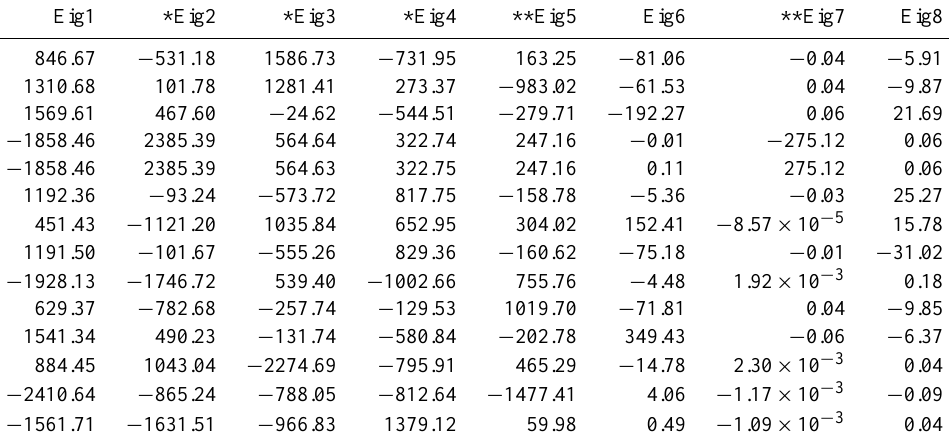
Table 3. Redundancy and partial redundancy analyses that quanti- fied the amount (%) of community assembly variability explained by pure environmental (env), spatial (space), and spatially struc- tured environmental variables (env space ) , alongside the statistical significance of the model (set at p< 0.05, indicated by *), which for env space cannot be estimated using any method (Bocard et al., 2004) and thus was not applicable (NA). Spatial variability p model explained (%) Broad-scale env + space + env space